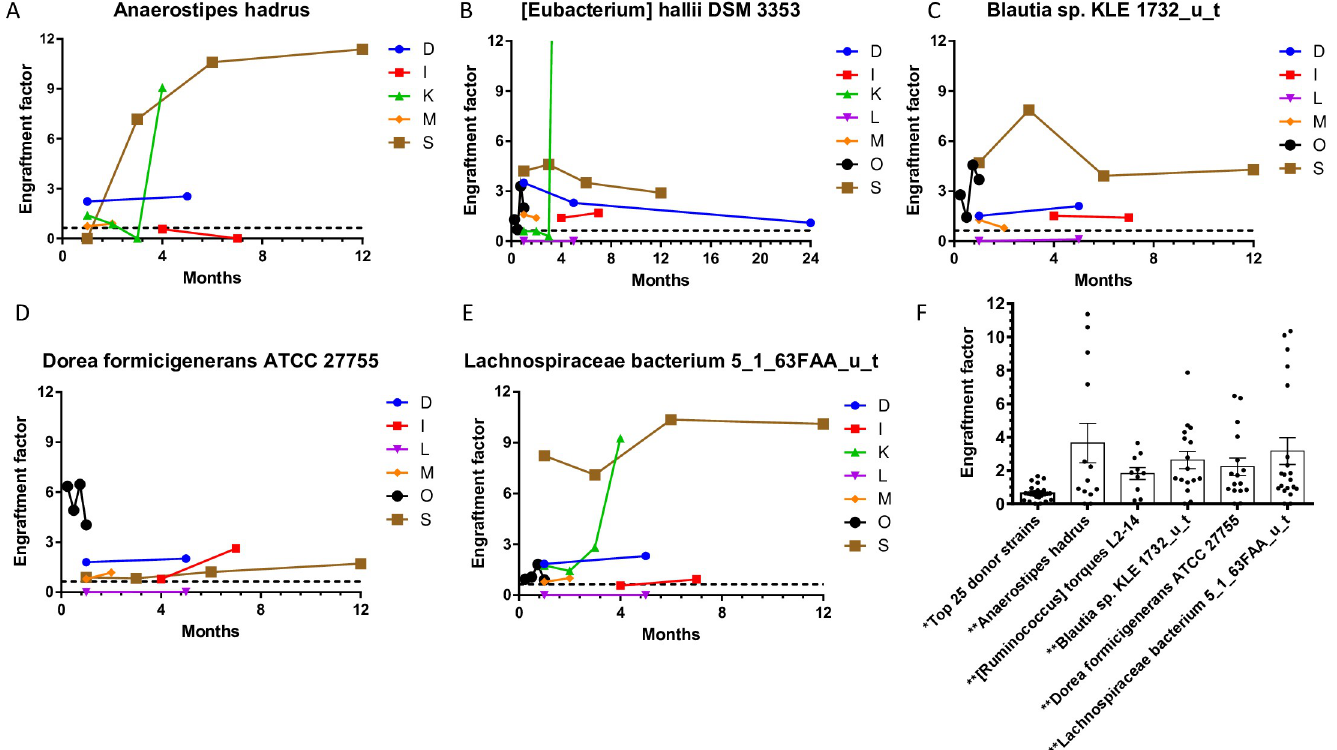
Fig 8. Longitudinal mapping of the engraftment factor of the top 5 engrafting strains in post-FMT patients, A) Anerostipes hadrus , B) [Eubacterium] halli DSM 3353 , C) Blautia sp . KLE 1732_u_t , D) Dorea formicigenerans ATCC 27755 , and E) Lachnospiraceae bacterium 5_1_63FAA_u_t . 8F) Column scatterplot depicting engraftment factor values for the top 5 engrafted bacterial strains from healthy donors in patients with RCDI after FMT as compared to the mean engraftment factor value of top 25 bacterial strains.